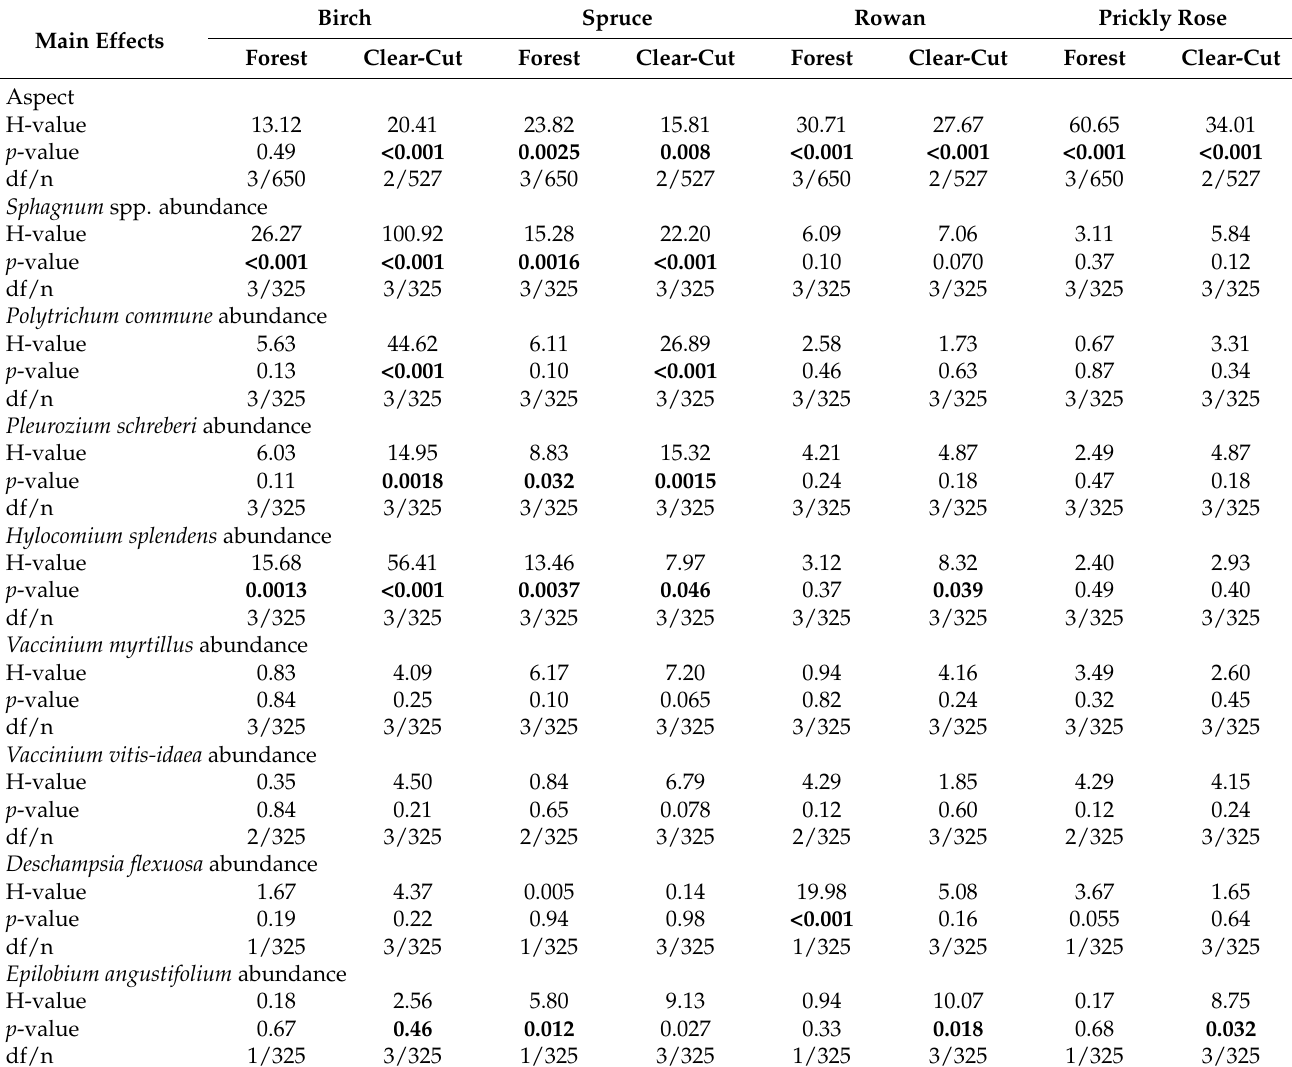
Table 2. ANOVA results for the distribution of young birch, spruce, rowan, and prickly rose plants in the ecotone complex in connection with microhabitat ecological and coenotic